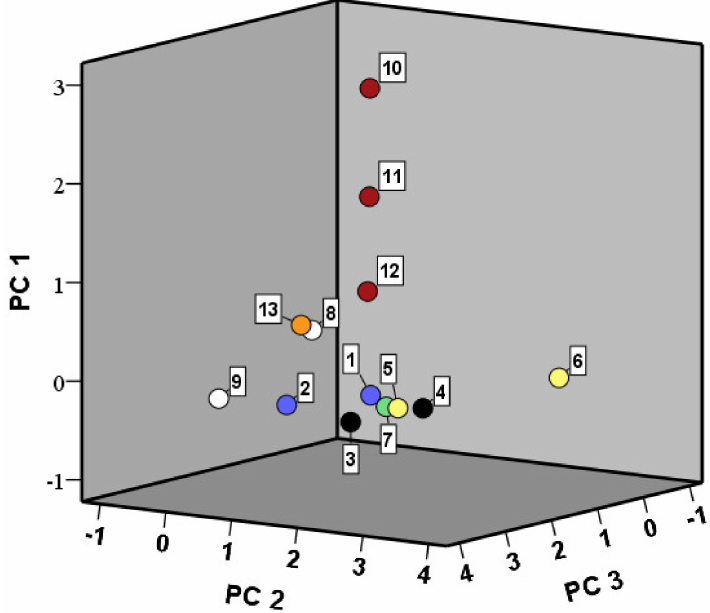
Figure 7. Principal component analysis (PCA) of the normalized peak areas of the volatile organic compounds present in the starter culture-initiated sourdough productions after 72 h of fermentation. The numbers indicate the di ff erent starter cultures used: 1, Limosilactobacillus fermentum IMDO 222 (LF1); 2, Liml. fermentum IMDO 222 (LF2); 3, Latilactobacillus sakei CTC 494 (LS1); 4, Latl. sakei